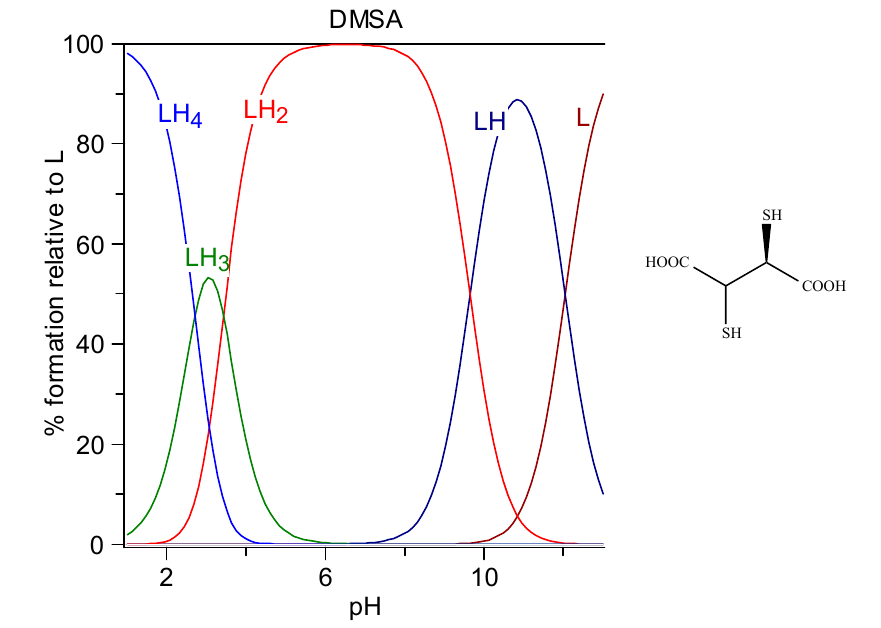
Figure 3. Speciation plots of DMSA.